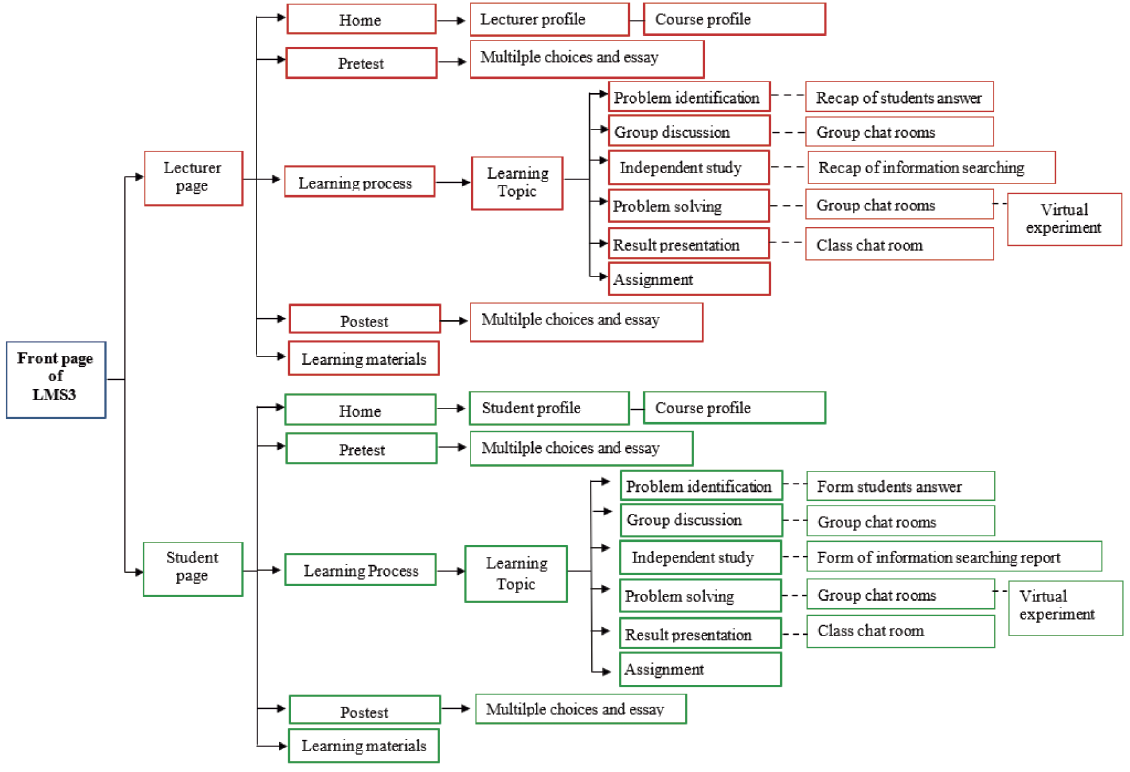
Figure 1. Flow chart system of LMS3 in Physics for school